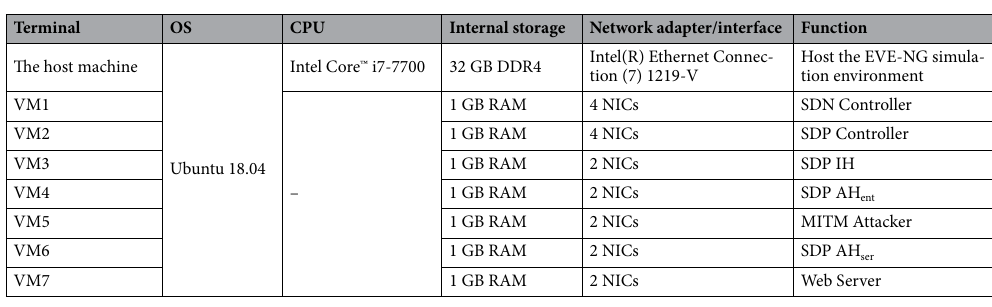
Table 4. Configuration of the experimental